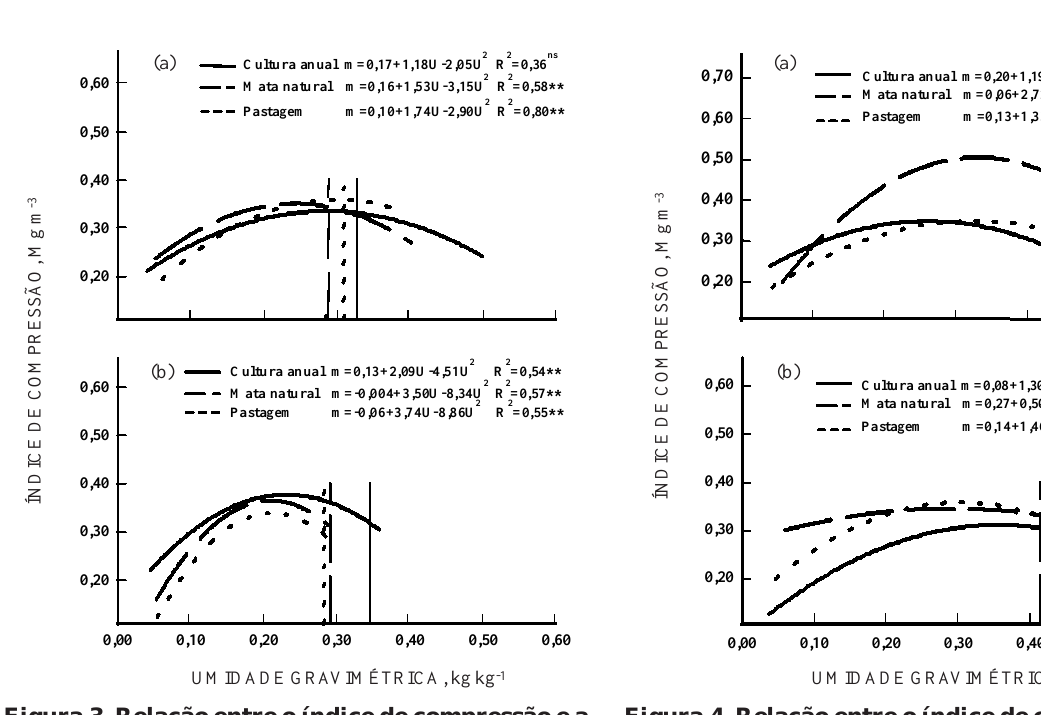
Figura 3. Relação entre o índice de compressão e a umidade gravimétrica para o Latossolo Vermelho-Amarelo sob as condições de cultura anual, mata natural e pastagem, nas profundi- dades de 0-0,03 m (a) e 0,27-0,30 m (b), com n = 15 (as linhas verticais representam os respectivos limites de plasticidade, com três repetições).